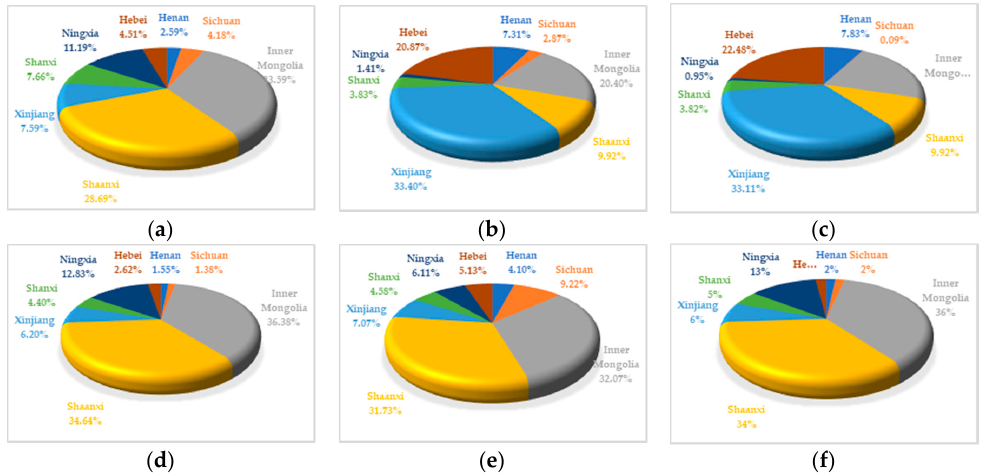
Figure 6. Weightage of the various environmental impact potentials of the eight provinces in natural gas liquefaction stage (per year): ( a ) Global Warming Potential (GWP), ( b ) Acidification Potential (AP), ( c ) Eutrophication Potential (EP), ( d ) Photochemical Ozone Creation Potential (POCP), ( e ) Dust Potential (DP), and ( f ) Total Environmental Impact Potential.